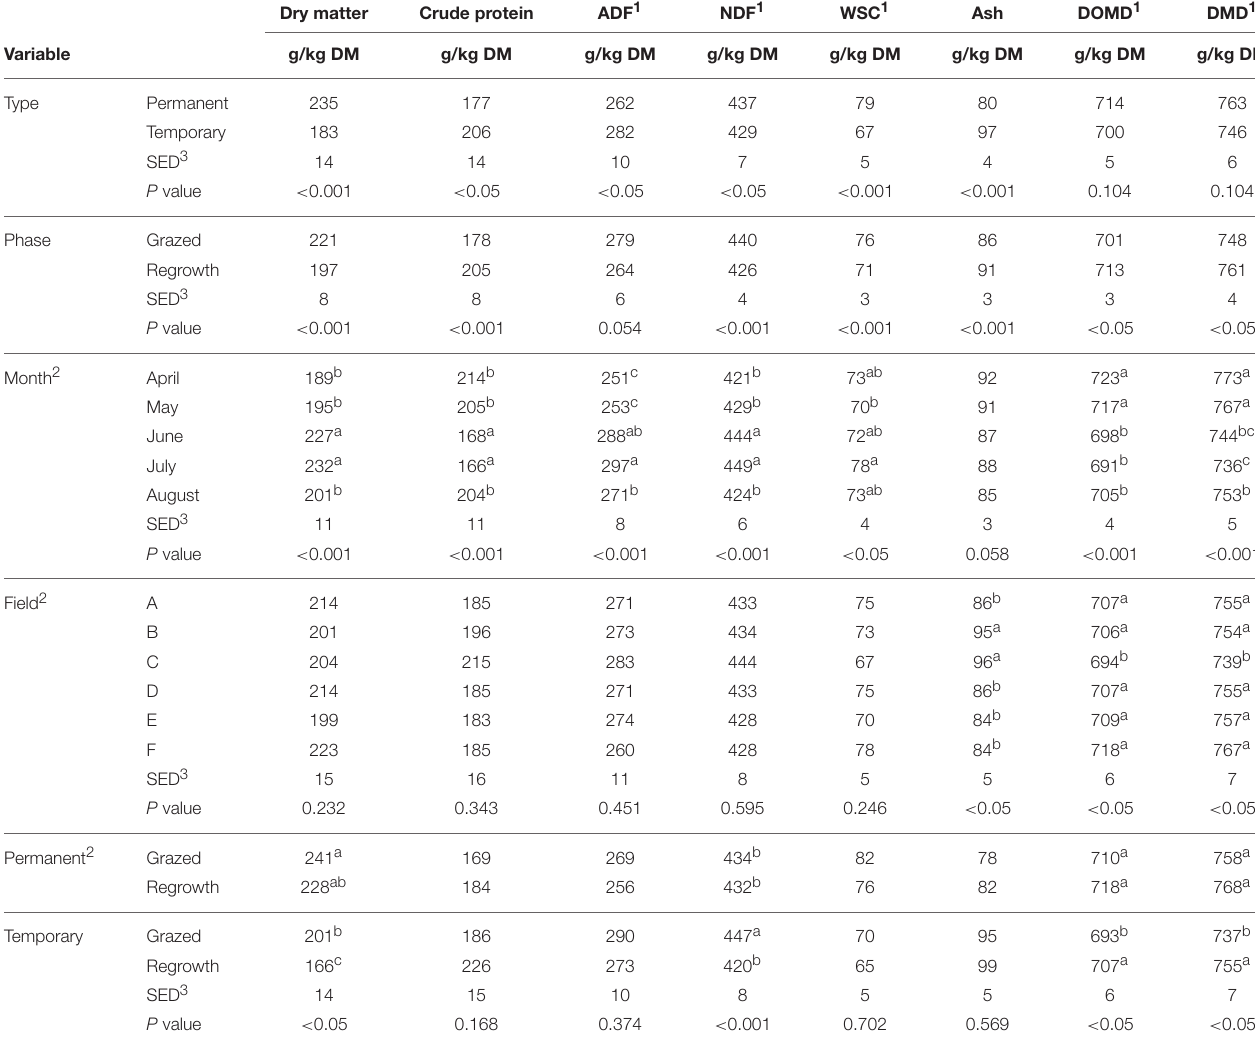
TABLE 5 | Effect of pasture type (permanent or temporary), phase of production (grazed or rested for regrowth), month of year (April to August) and field (A to F) on pasture nutrient